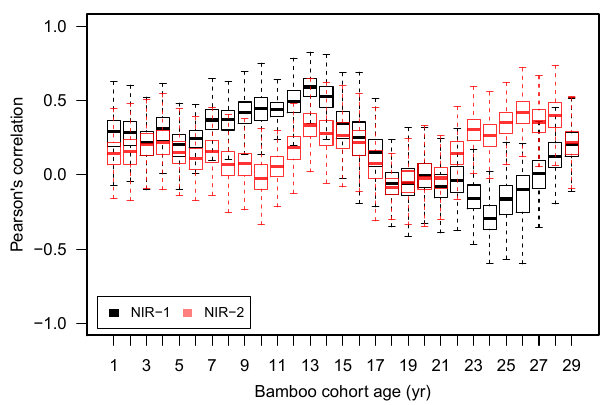
Figure 8. Pearson’s correlation coefficients between the median re- flectance of bamboo-free forest with the pixel spectral response of bamboo-dominated forests. The results are plotted as a function of the bamboo cohort age for MODIS NIR-1 (in black) and NIR-2 (in orange).